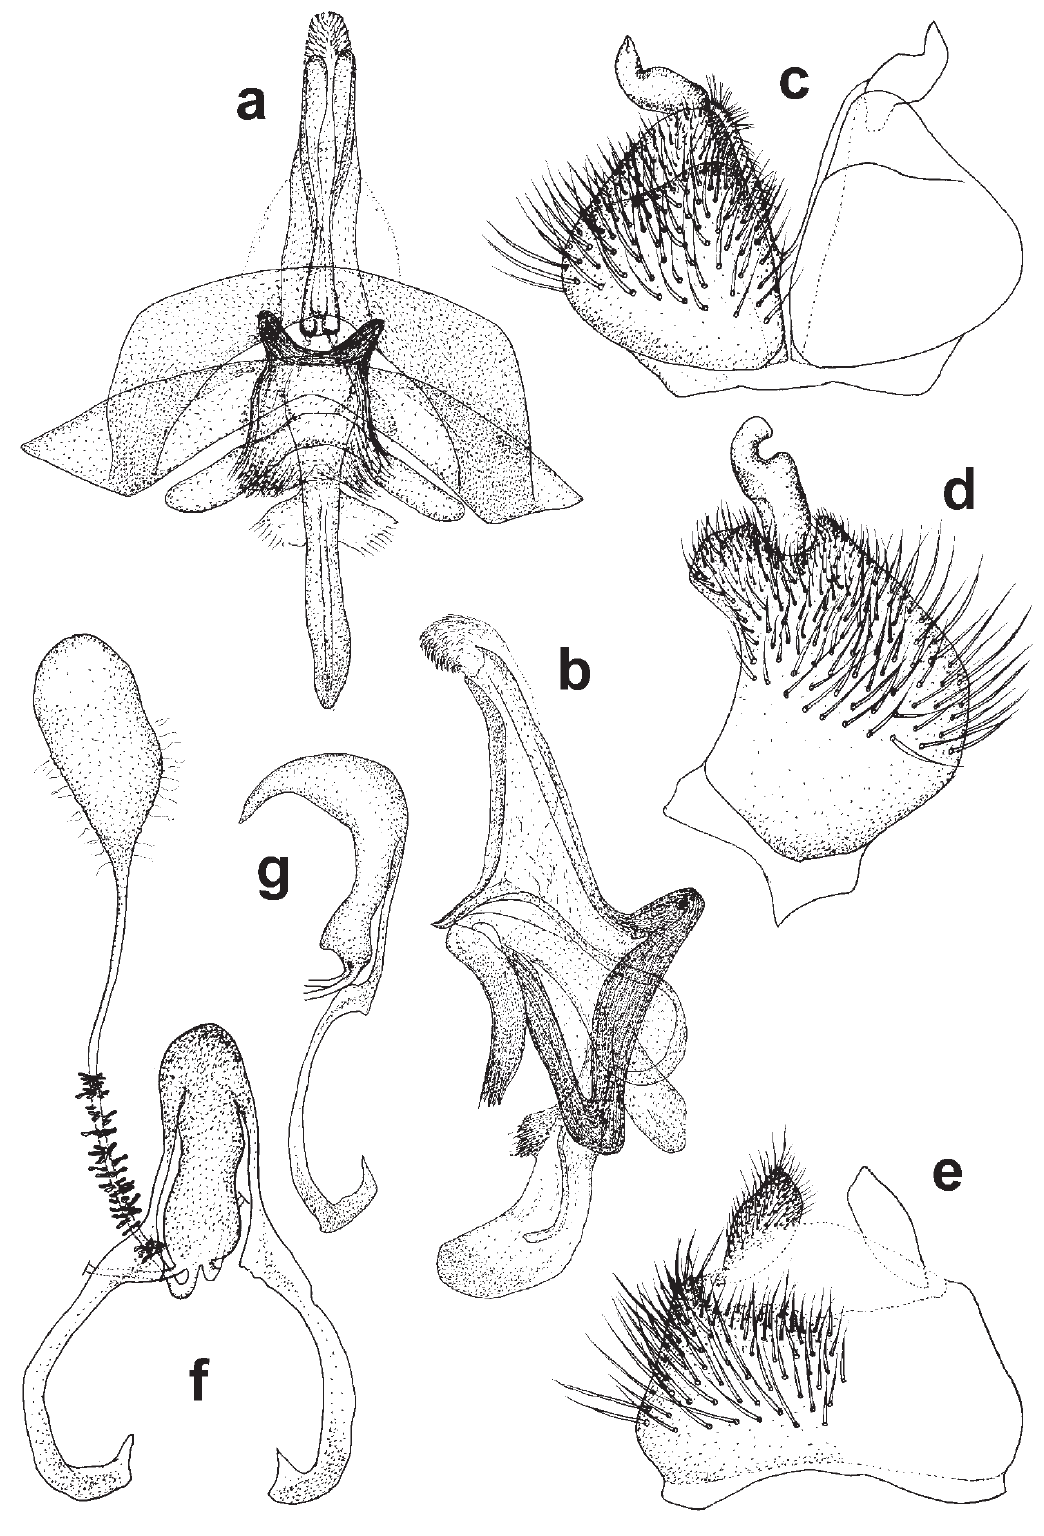
Fig. 41. Protypusia incisa (Wiedemann, 1830) gen. et comb. nov. a . Epiphallic complex ventral. b . Epiphallic complex lateral. c . Gonocoxite ventral. d . Gonocoxite lateral. e . Epandrium dorsal. f . Female genitalia ventral. g . Female genitalia